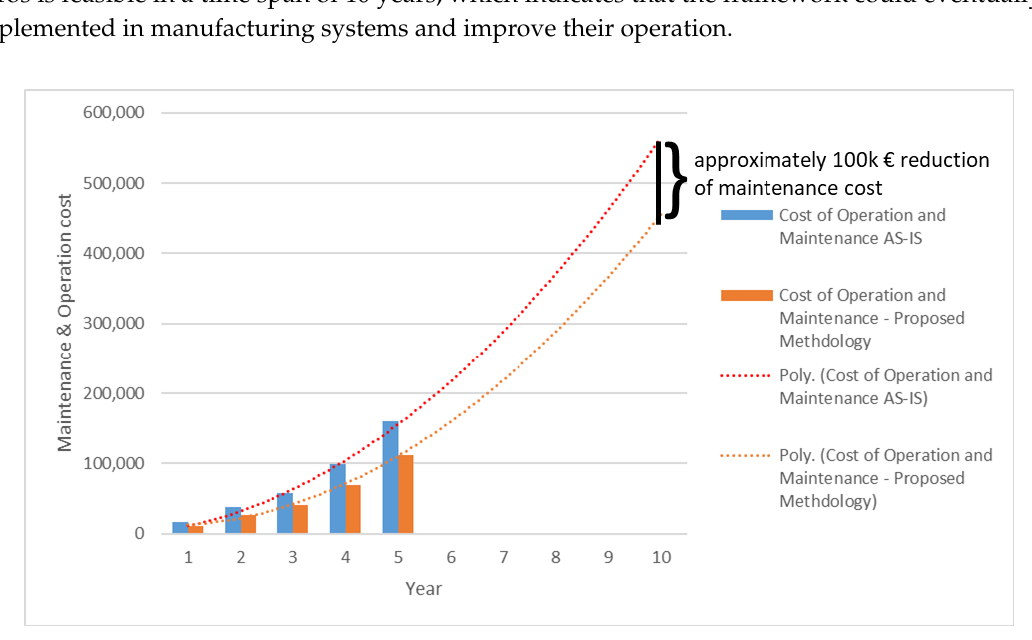
Figure 8. Cost of operation and maintenance analysis.